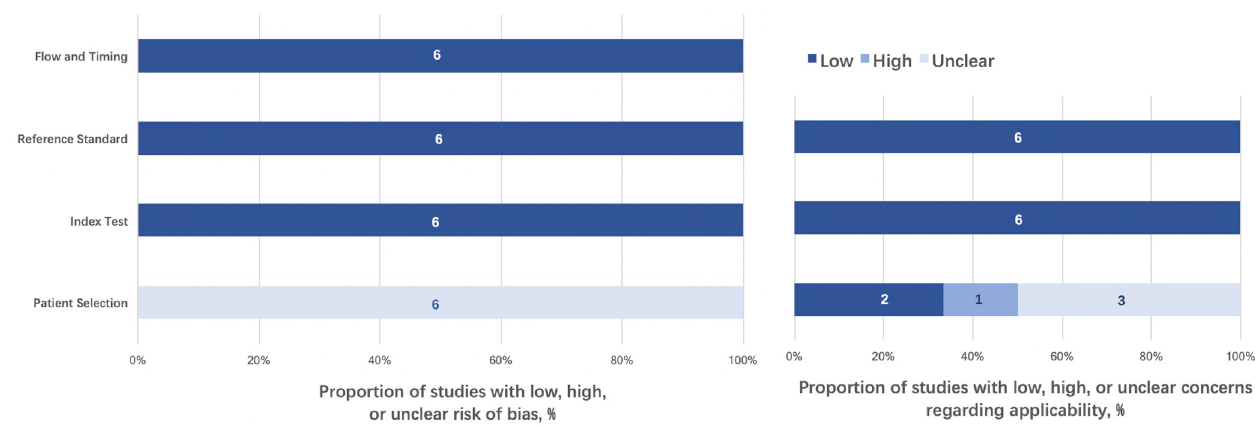
Fig 3. Graphical display for quality assessment of selected studies using modified QUADAS-2 tool. All of the studies were rated as ‘unclear’ in terms of the potential bias in patient selection, since they were all retrospective and did not report the enrollment strategy of patients (consecutively or randomly). As the exact meanings of ‘diagnostic tests’, ‘index tests’ or ‘reference standard’ differed from their original interpretations in this research field, the risk for bringing ‘index tests’ bias was considered low after our careful evaluation. Since all studies used SRK/T as a relative reference, the risk of bias was regarded as low for ‘reference standard’. Regarding time flow, all studies were of high quality. QUADAS-2: Quality Assessment of Diagnostic Accuracy Studies-2.